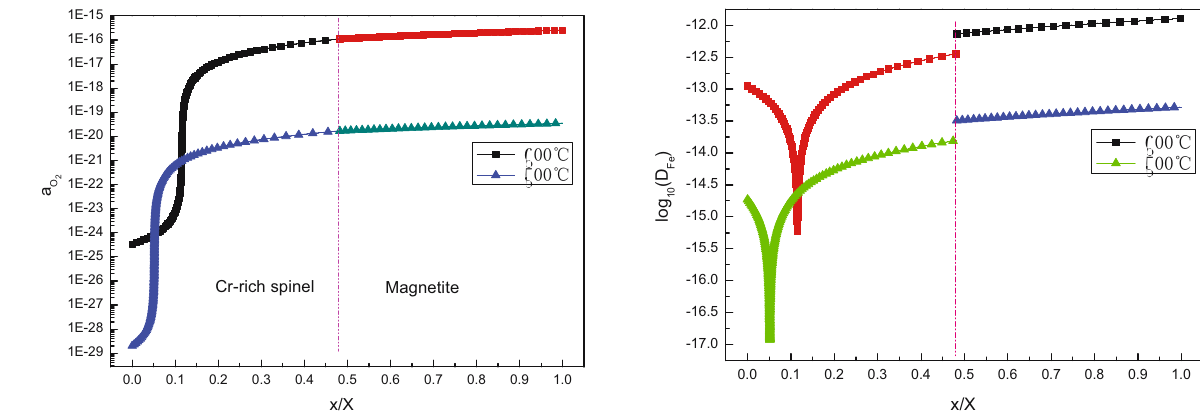
Figure 5: Model predictions of oxygen activities in oxide scale on HCM12A as a function of normalized position.